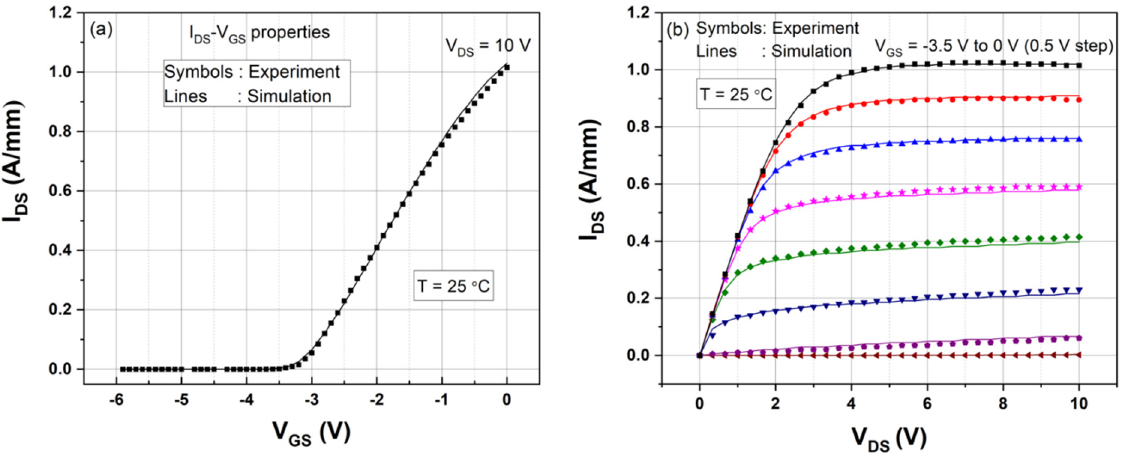
Figure 11. Simulated ( a ) transfer ( I DS –V GS ) and ( b ) output ( I DS –V DS ) properties of the Fe-doped AlGaN/GaN HEMT are validated with the measured DC results.